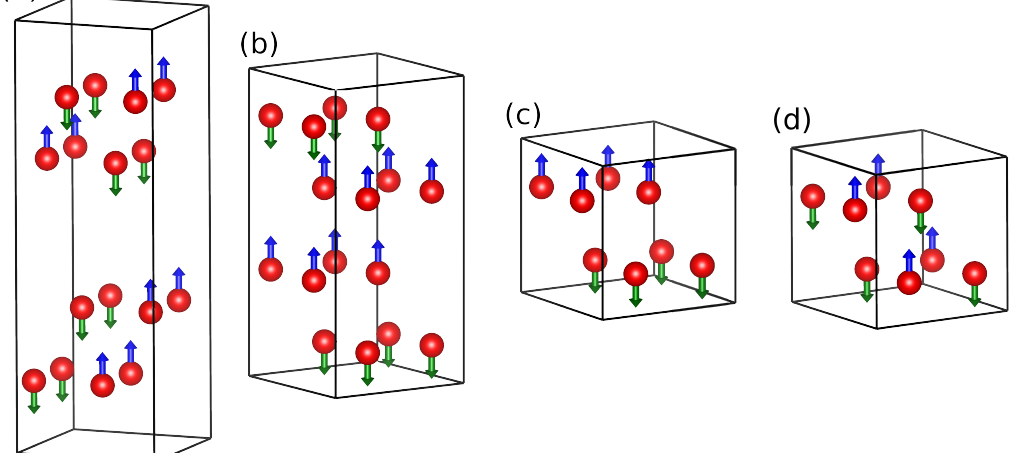
Figure 3. The possible AFM configurations of RTe (with the non-magnetic Te ions hidden): ( a ) stripe (only relevant for RTe 3 ), ( b ) ABBA interlayer (only relevant for RTe 2 ), ( c ) ABAB interlayer, and ( d ) intralayer (c and d apply to both RTe 3 and RTe 2 structures but are demonstrated here using RTe 2 ). The calculated total energies of the various configurations are presented in Table